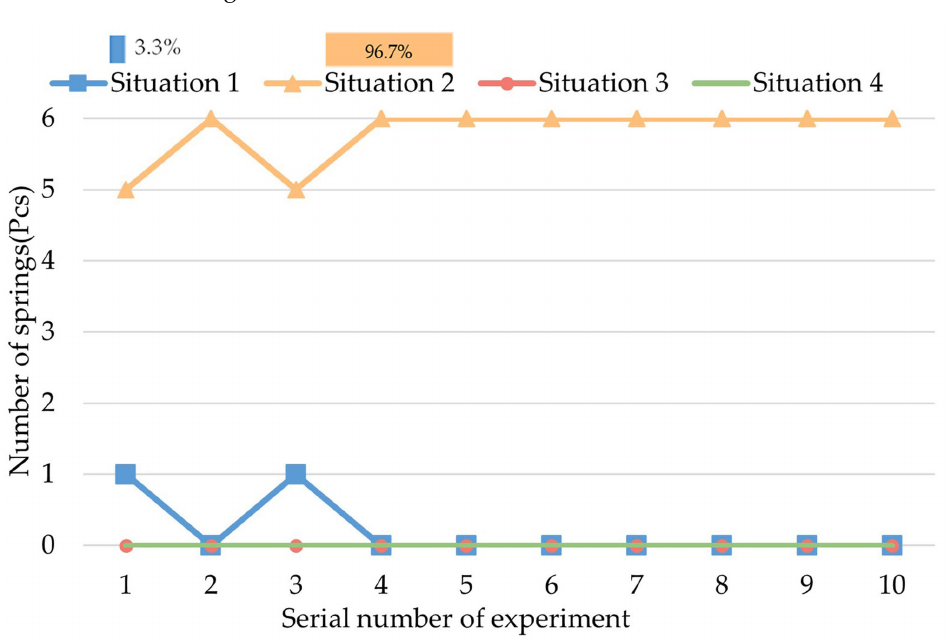
Figure 11. Result of Group II of experiments.